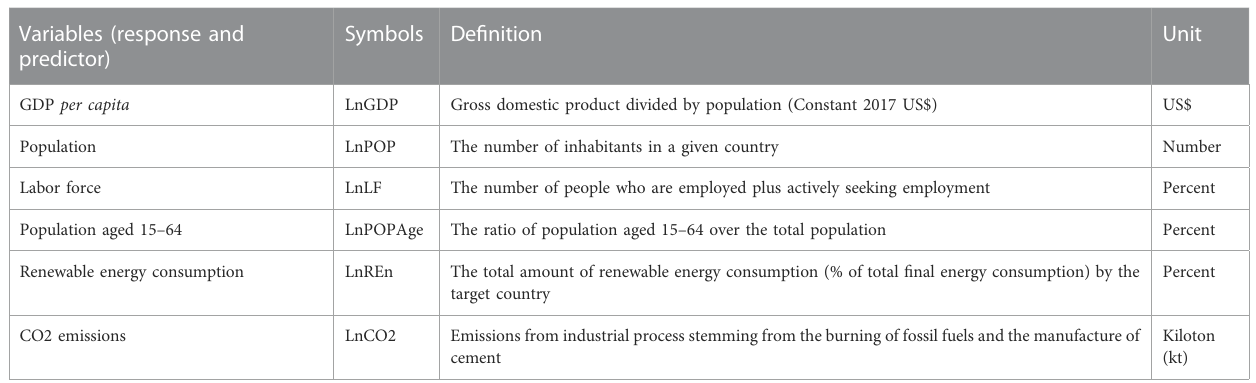
TABLE 2 De fi nitions of